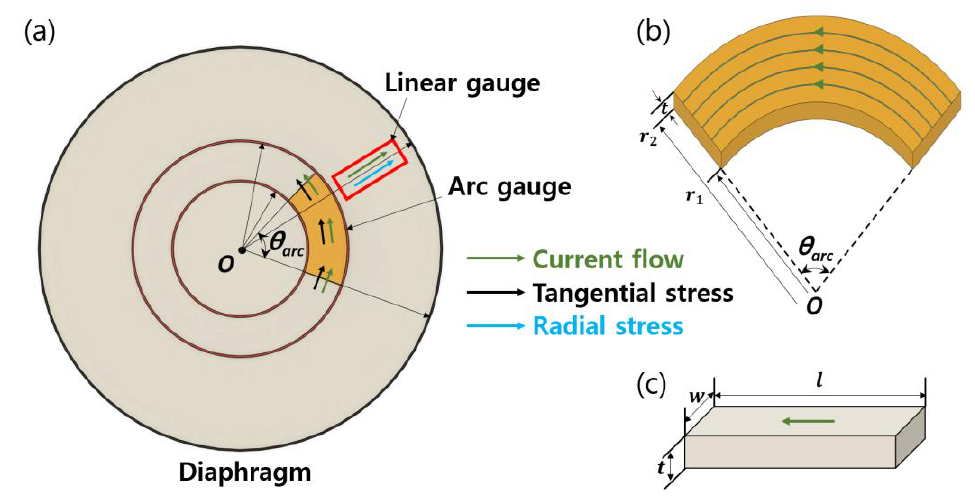
Figure 3. Design principle of arc and linear gauges on a circular diaphragm. ( a ) Locations of tangential (arc) gauge and radial (linear) gauge. Models of ( b ) arc-shaped and ( c ) linear piezoresistors.